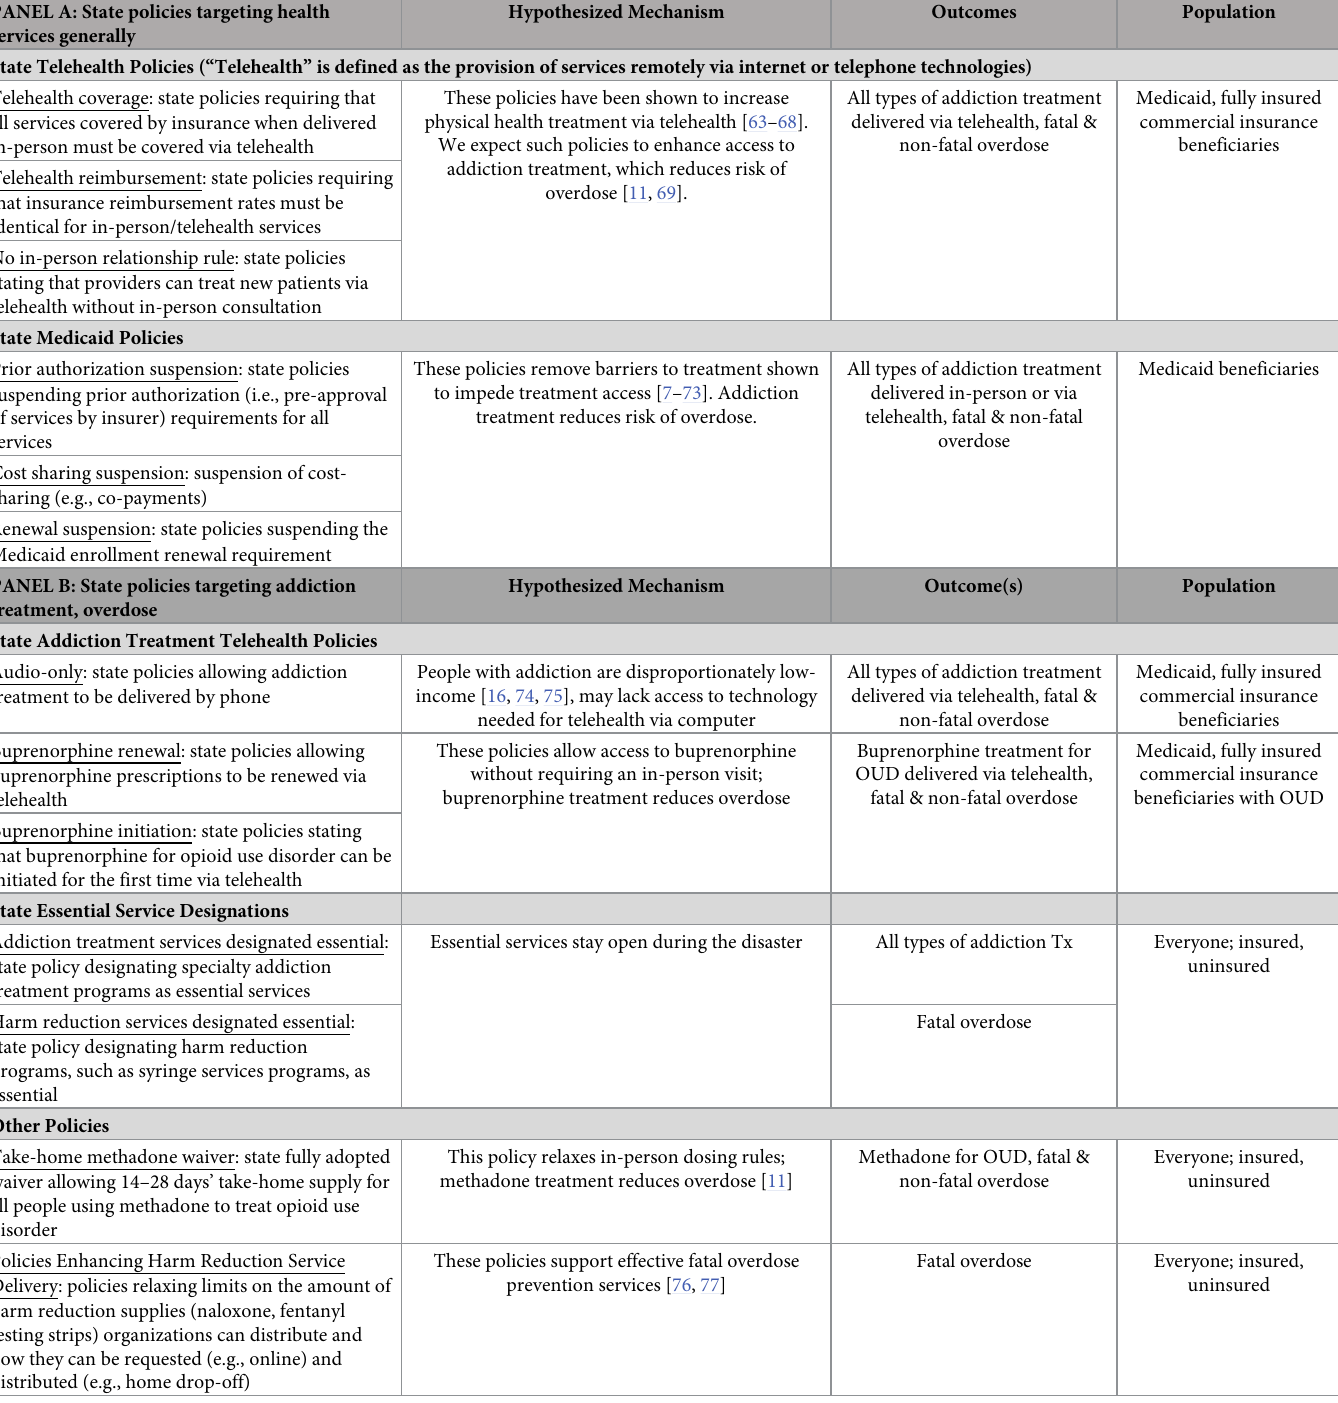
Table 1. State policies that may mitigate disruptions to health service delivery during/after disasters. PANEL A: State policies targeting health services